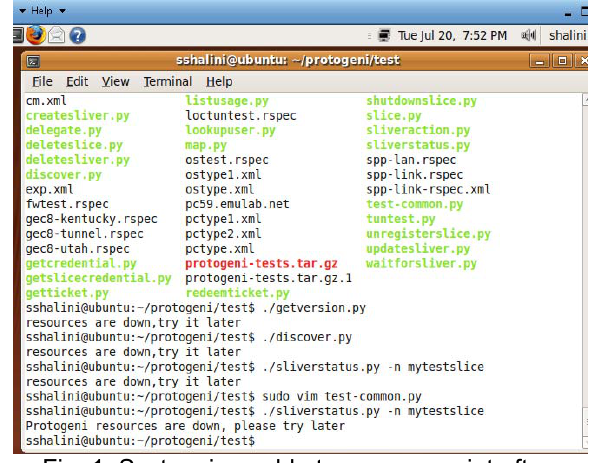
Fig. 1: System is unable to run any script after changes in test-common.py